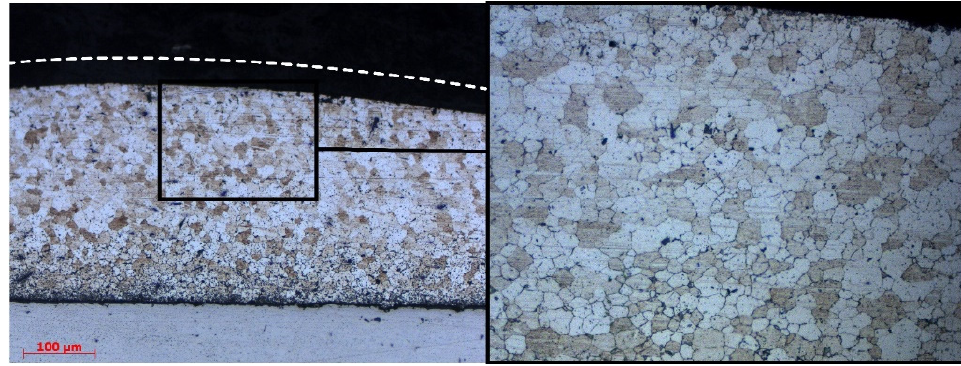
Figure 4. Microstructure of sample AS-01 under a 7350 N load force and at 2000 RPM.